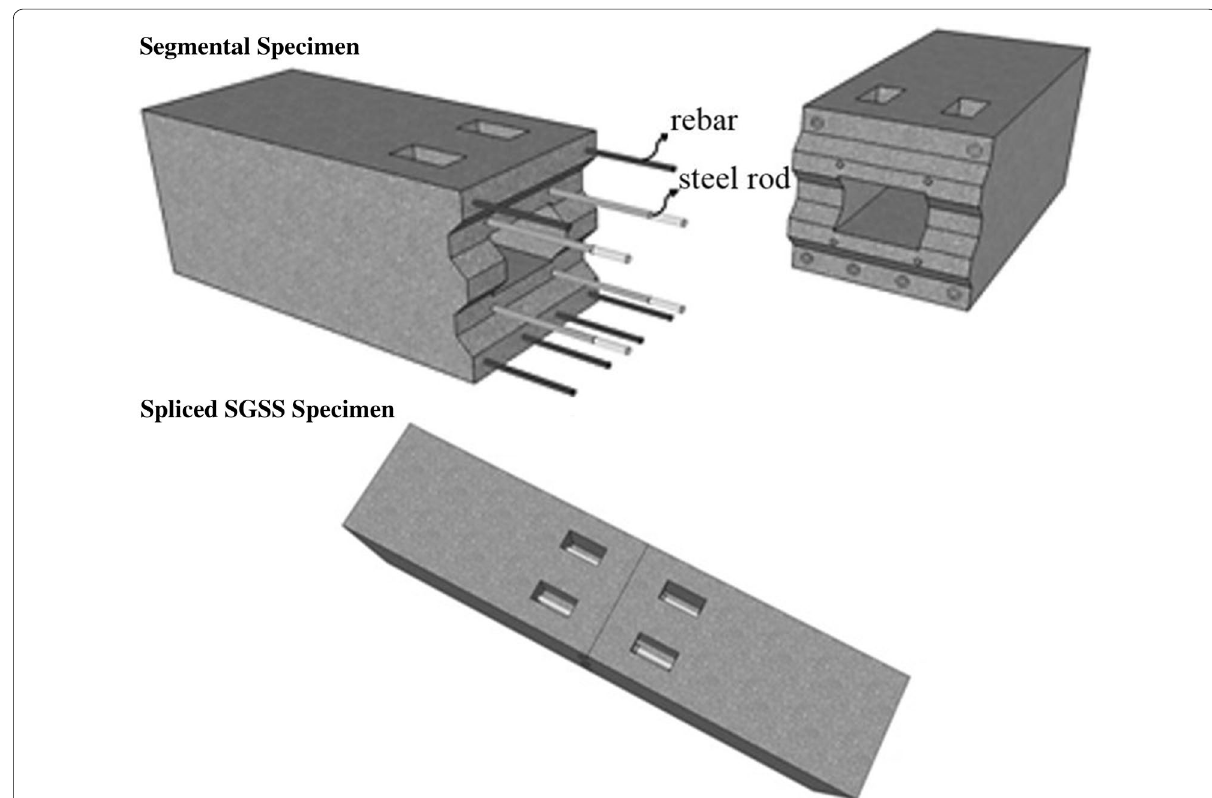
Fig. 6 Specimen manufacturing process of SGSS specimen.